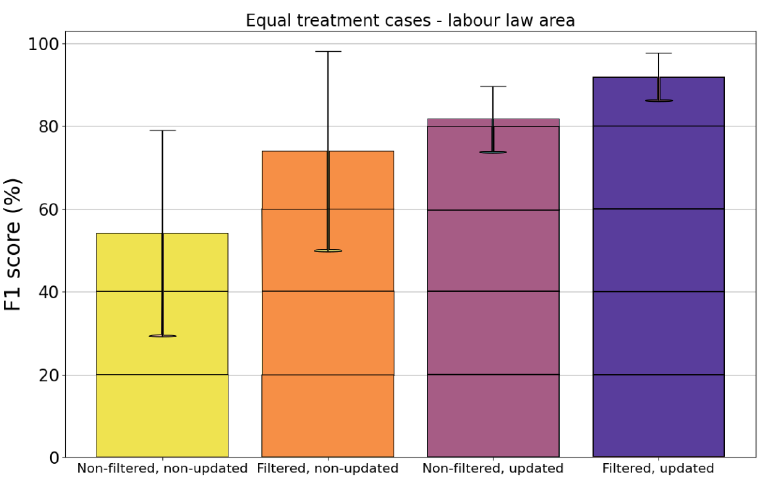
Figure 7. Effect of negative filtering and positive training data